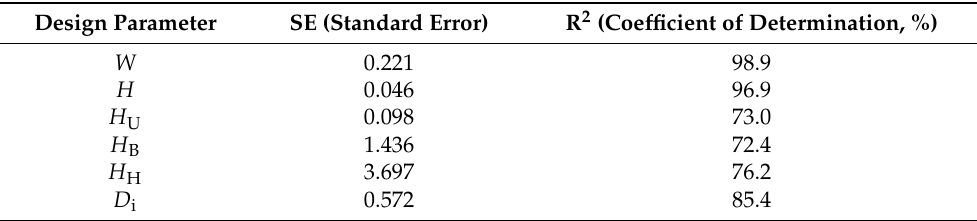
Table 11. Analysis variance tests for predicted model for welding